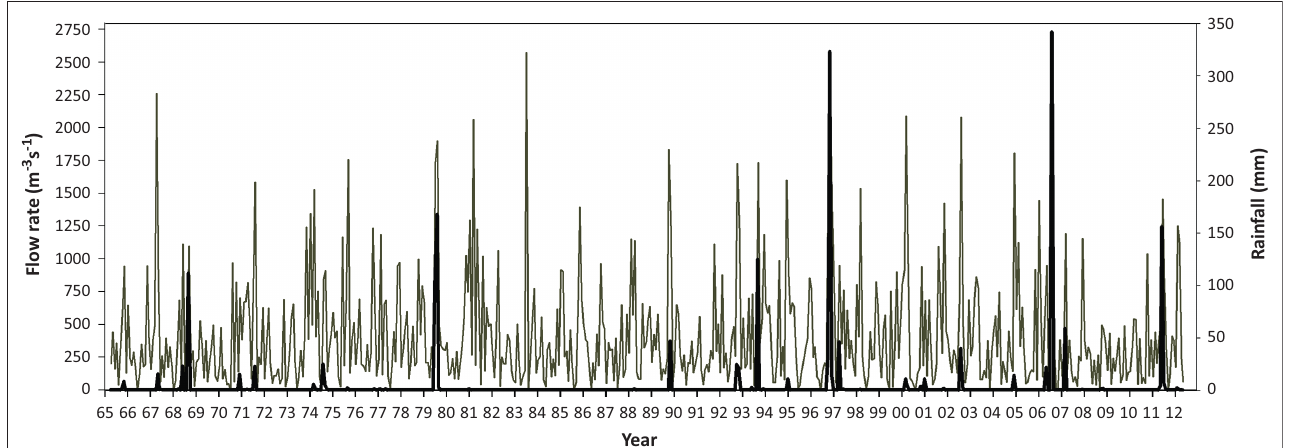
FIGURE 2: Monthly peak flows (black) at the Wincanton gauging weir on the Elands River and total monthly rainfall (grey) at Groendal Dam (16 February – 11 January 2006) and at Uitenhage (30 November 2006 – 05 January 2012) illustrating rainfall and flow variability in the headwater tributaries of the Swartkops River system (flow data are missing for the period April 1981 – September